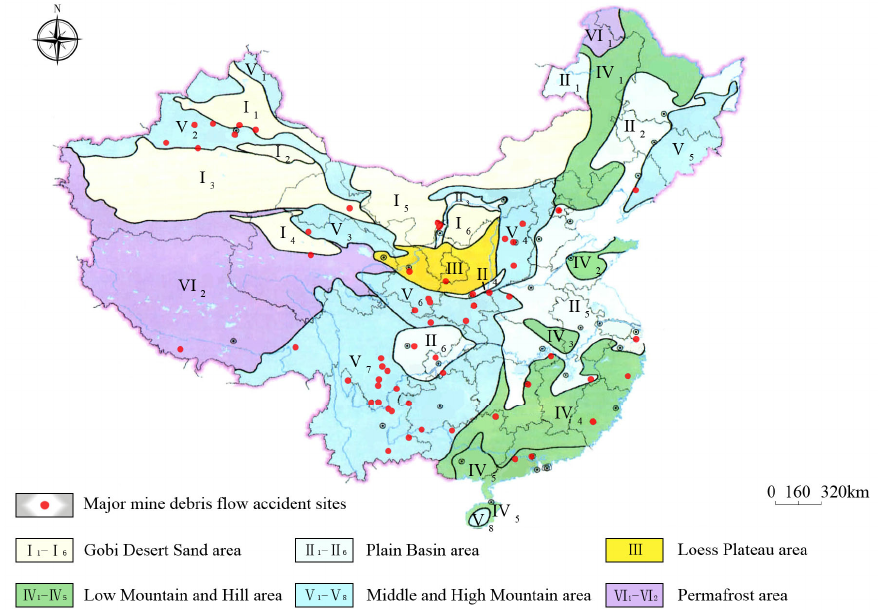
Figure 4. Distribution map of major mine debris flow disasters (Mainland China and Hainan Province only).